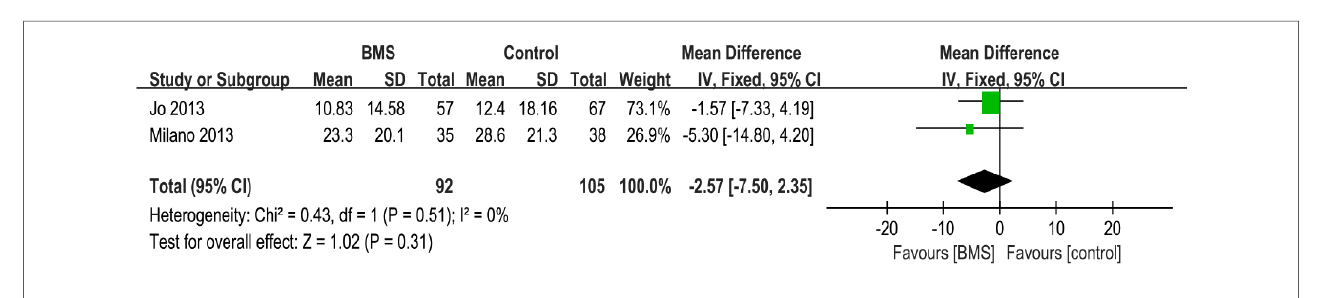
FIGURE 7 Forest plot comparing postoperative DASH scores between the BMS and control